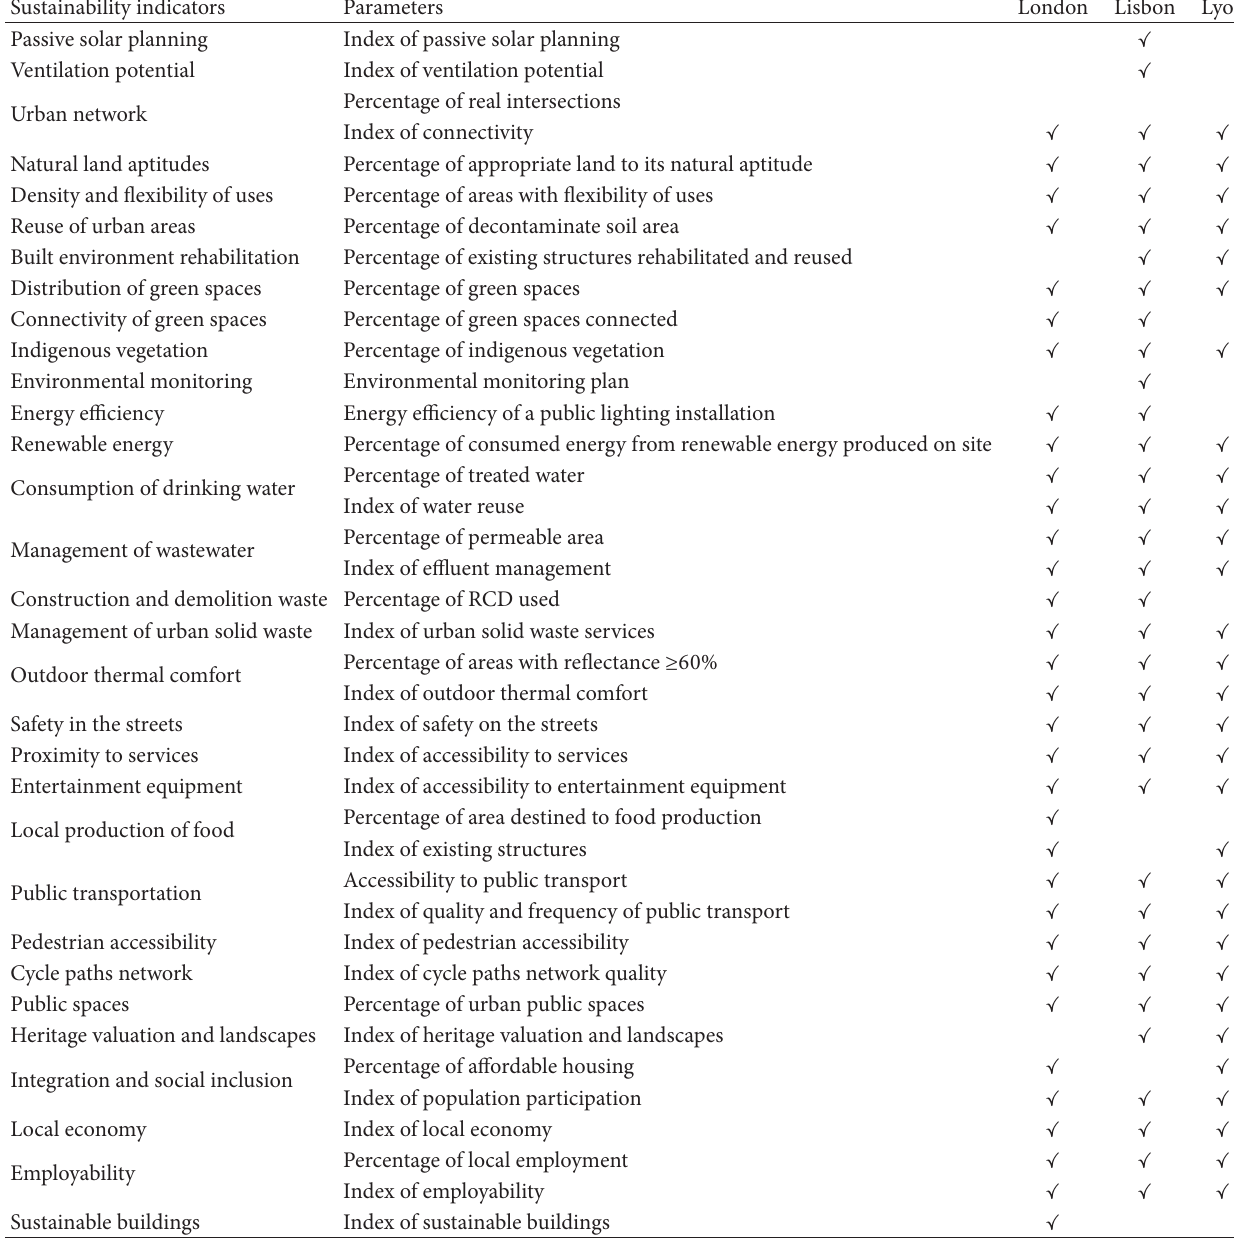
Table 2: Examples of urban sustainability indicators taken into account in the